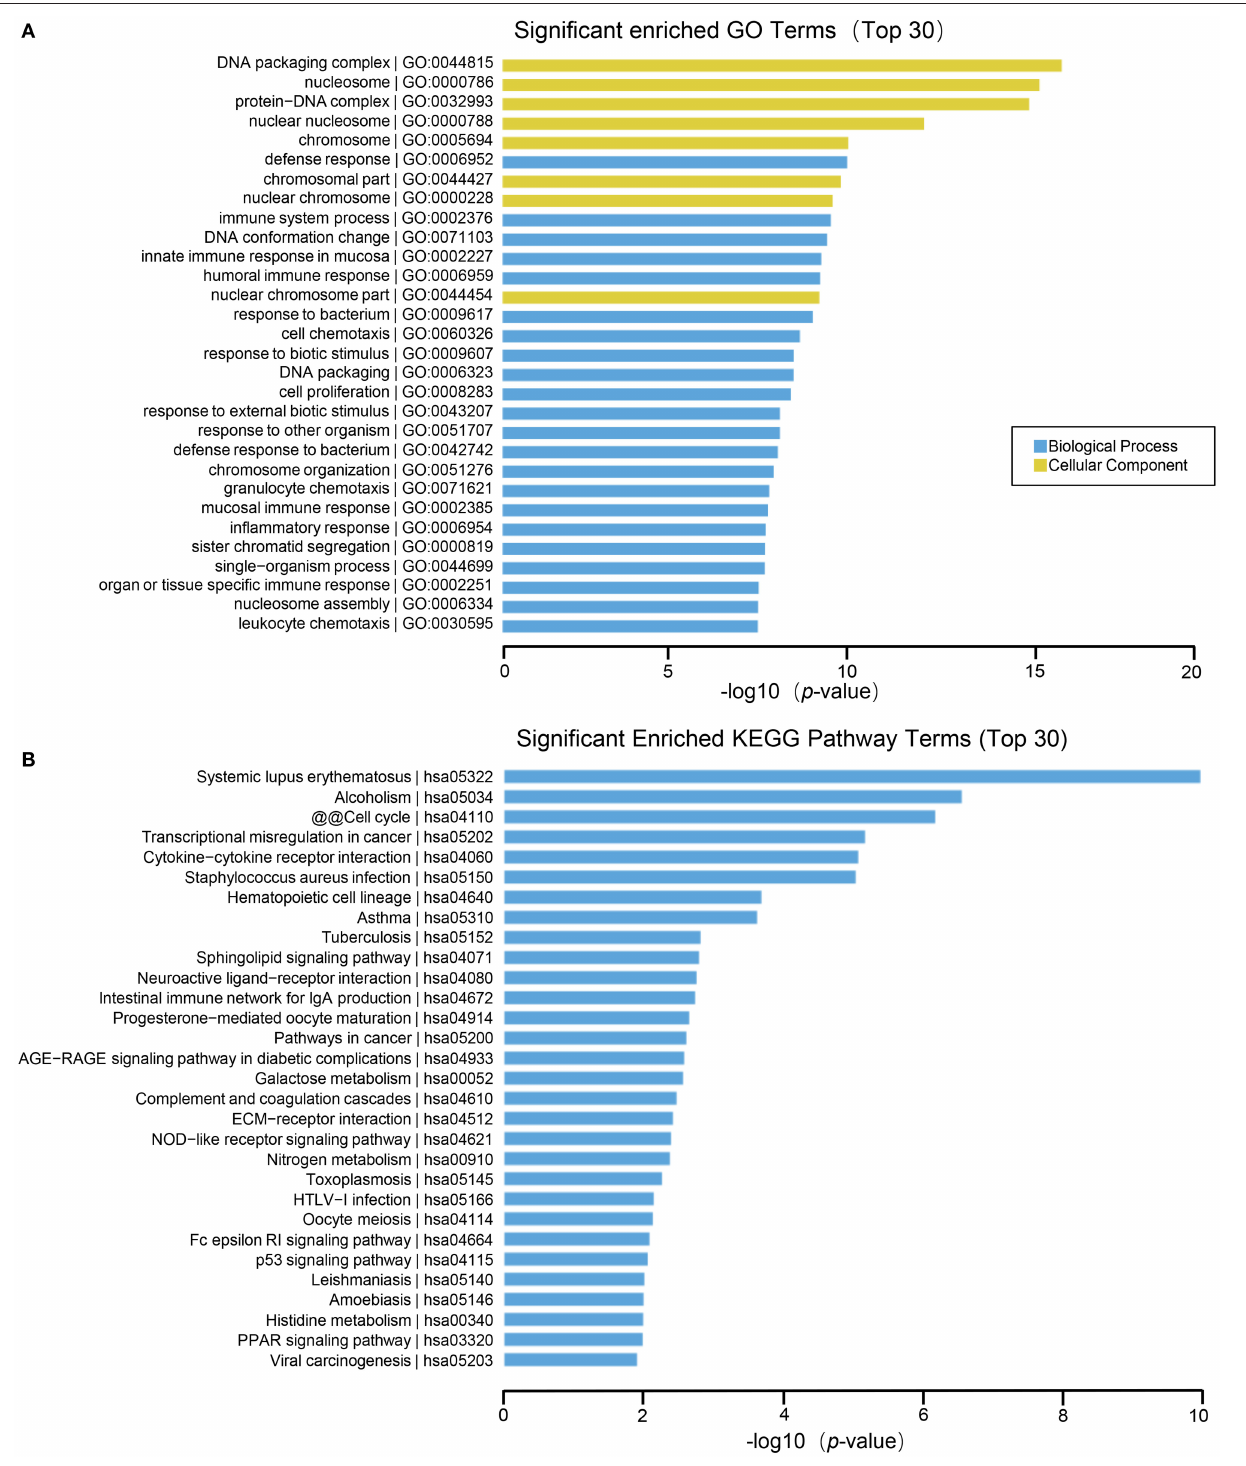
Frontiers in Neuroscience | www.frontiersin.org